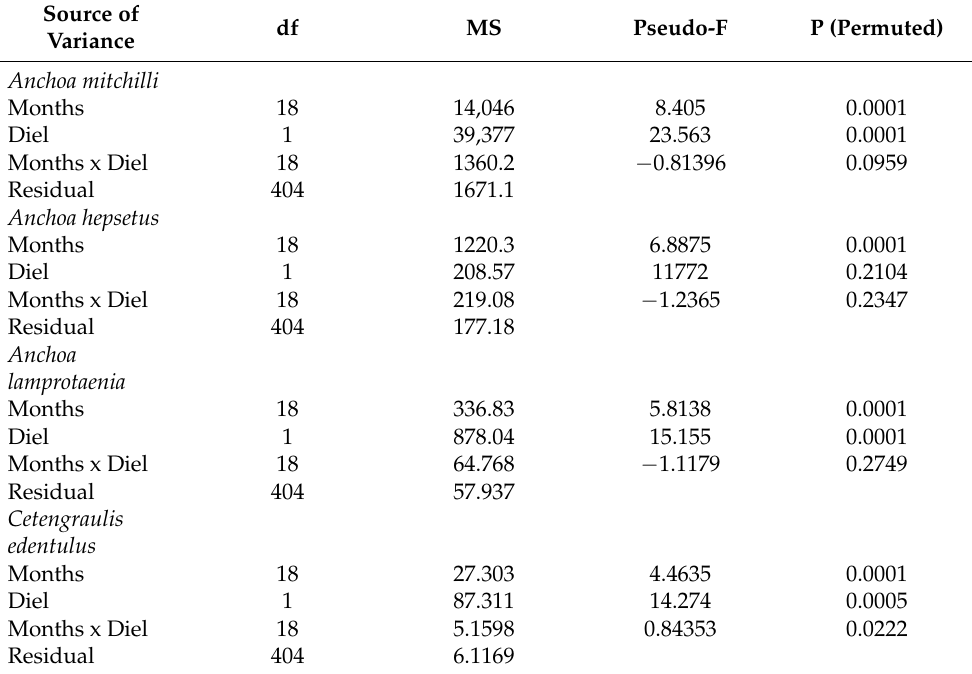
Table 1. Results from univariate two-way permutational analysis of variance (PERMANOVA) to test effects of month and diel period (day/night) on the relative abundance of